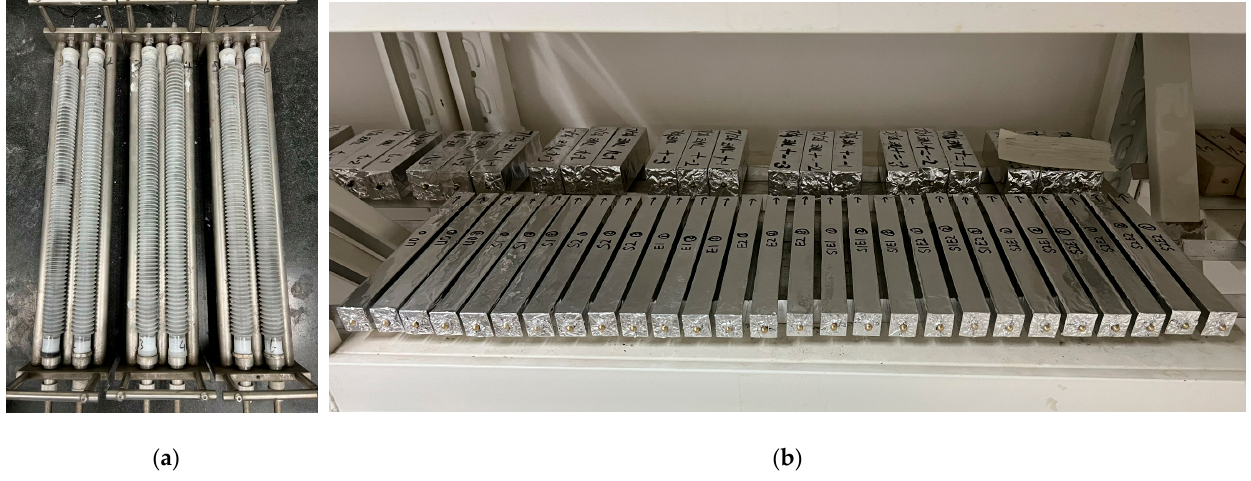
Figure 2. Samples in autogenous shrinkage test. ( a ) Specimens for early deformation (0–3 d) test; ( b ) Specimens for later deformation (3 d–28 d)